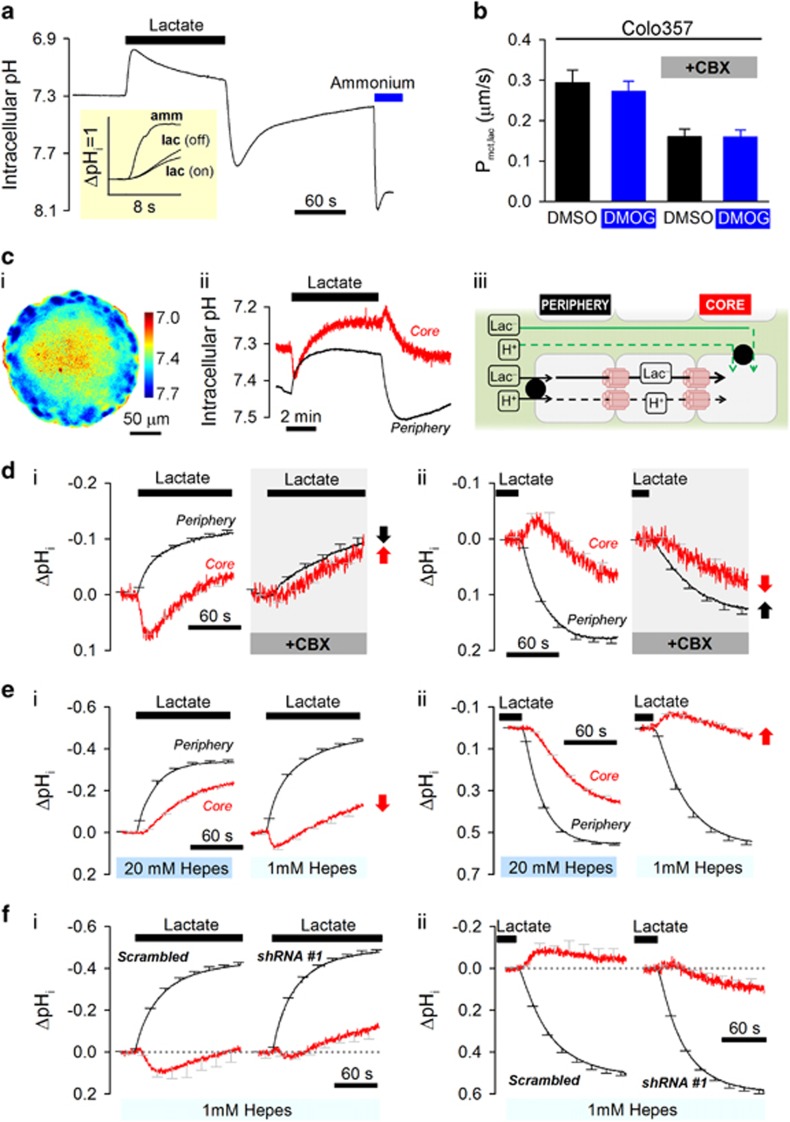
Intracellular lactate diffuses ahead of H+ ions in Colo357 spheroids. (a) pHi response in cSNARF1-loaded Colo357 monolayer to 40 mm lactate-containing solution (probes MCT activity) followed by 30 mm ammonium-containing solution (tests speed of solution change). Inset: lactate-evoked pHi changes are not rate-limited by solution change. (b) Membrane lactate permeability (Pmct,lac) calculated from MCT activity. Gap junctional blocker CBX (100 μm) had partial inhibitory effect on Pmct,lac. Mean±s.e.m. (N=20, 19, 20, 19). (c,i) pHi map through equatorial plane of cSNARF1-loaded Colo357 spheroid (radius 110 μm). (ii) pHi dynamics in peripheral layer (11 μm-thick rim; black time course) and core (radius 11 μm; red time course). (iii) Two routes of lactate entry into cells at the spheroid core. (d) pHi response, in presence of CO2/HCO3−, to (i) adding and (ii) removing lactate. Biphasic response at core is blocked by CBX (100 μm; paired experiment). Mean±s.e.m. (N=8). (e) pHi response, in absence of CO2/HCO3−, to (i) adding and (ii) removing lactate; extracellular buffering was provided by 20 mm or 1 mm Hepes (paired experiments). Mean±s.e.m (N=7). MCT activity at the core is rate-limited by slow H+ supply attained under a low (1 mM) [Hepes] buffering regime; this exposes a higher junctional component of lactate handling at the spheroid core. (f) Measurements in 1 mm Hepes performed on size matched spheroids grown from Colo357 cells transduced with shRNA #1 or scrambled construct. Unpaired measurements. Radius: 125.4±2.3 μm, 127.7±2.4 μm. Mean±s.e.m (N=5, 4).